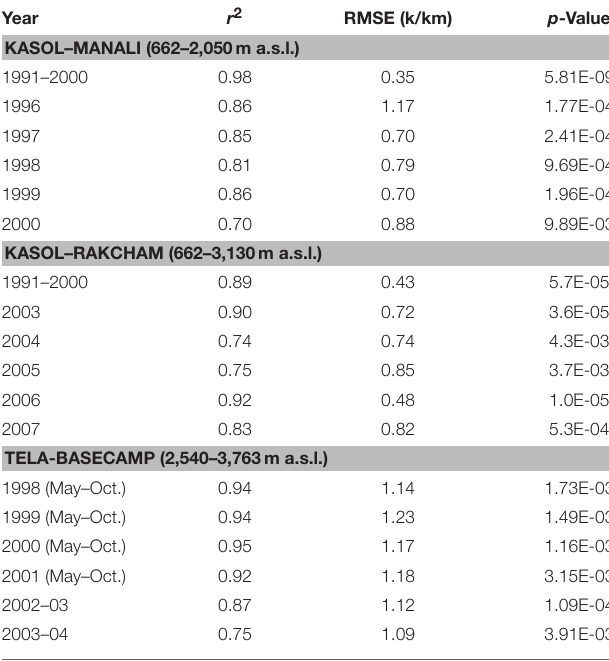
TABLE 3 | Details of error analysis from the preliminary test of the 5-year mean (1986–1990) SELR indices of Kasol–Manali